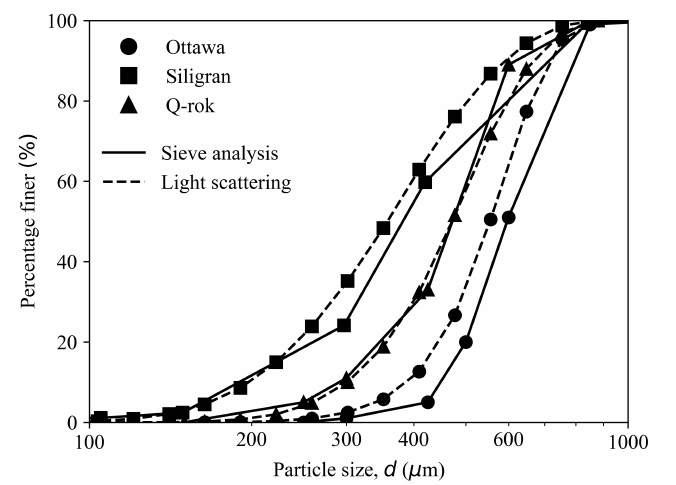
Figure 4. Particle size distribution determined by sieve and laser scattering analysis of Ottawa sand, Q-Rok sand, and Euroquarz